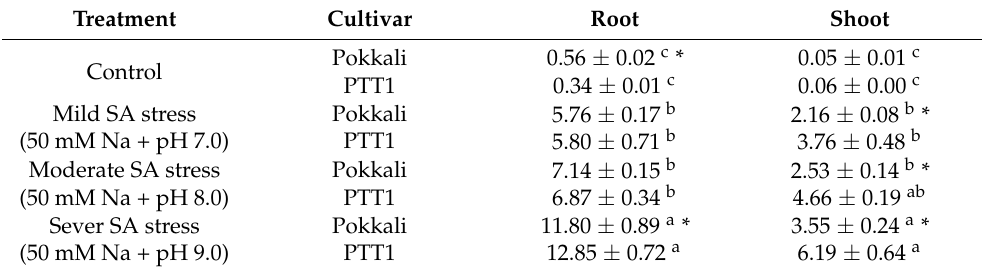
Table 1. Effects of saline-alkaline stress (mild, moderate, and severe) on the Na/K ratio of the roots and shoots of Pokkali and PTT1. Data are the means of 4 replicates ± S.E. Similar letters indicate no significant differences between the treatments in each variety ( p < 0.05). Asterisks show significant differences between Pokkali and PTT1 in each treatment ( p <